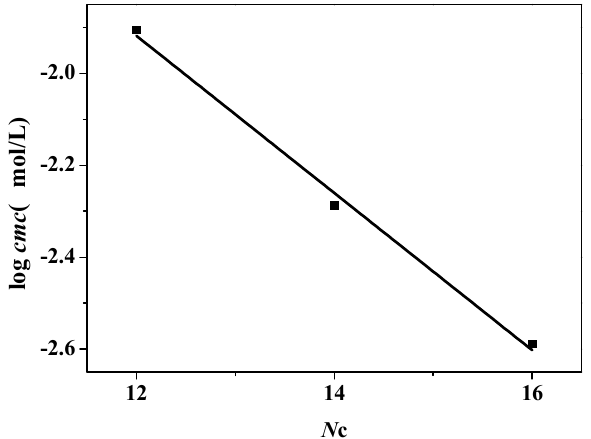
Figure 2. Plot of logarithmic cmc versus the number of carbon atoms in the hydrocarbon chain of C n PDB at 298.15